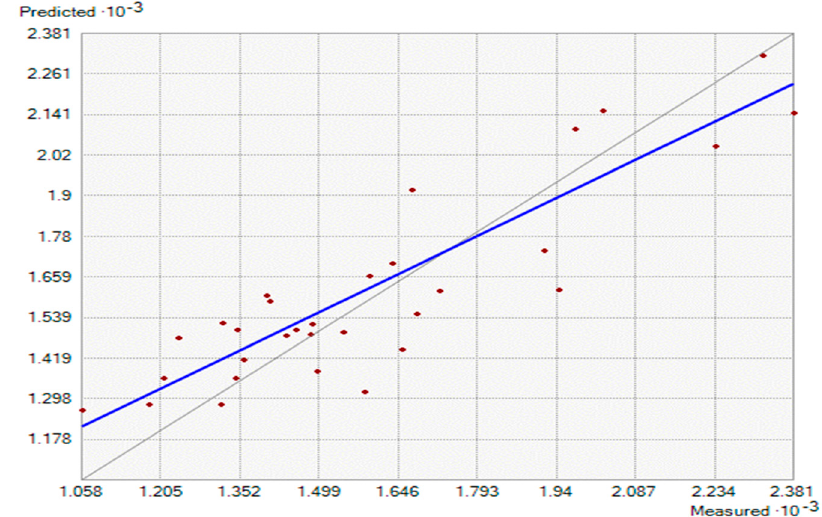
Figure 9. Prediction error line graph for mean annual total rainfall (OCK).